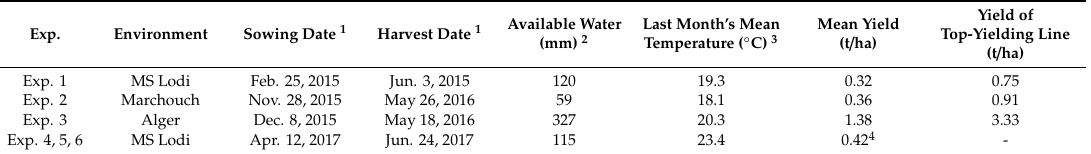
Table 1. Management, available water, air temperature in the last period of crop cycle and grain yield of pea experiments performed in a managed drought stress (MS) environment (Lodi, Italy) and two agricultural sites (Marchouch, Morocco; Alger,